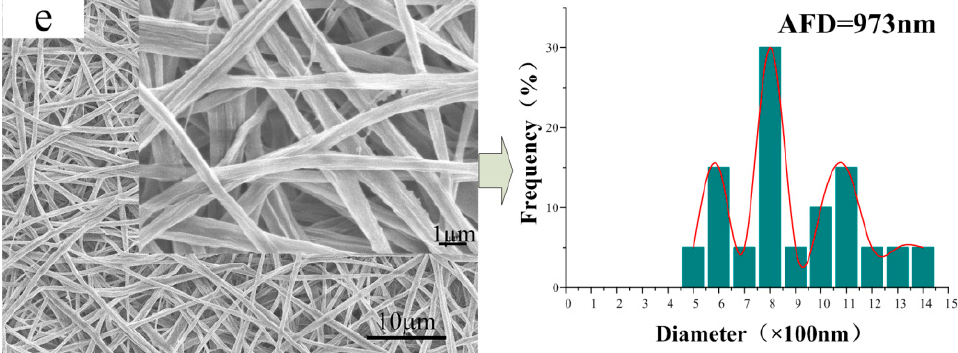
Figure 5. SEM images of a series of water-treated CA/PVP hybrid fibers with varying PVP contents: ( a ) 0%; ( b ) 0.5%; ( c ) 1%; ( d ) 2%; ( e ) 5%. The pictures on the right correspond to the diameter distributions.